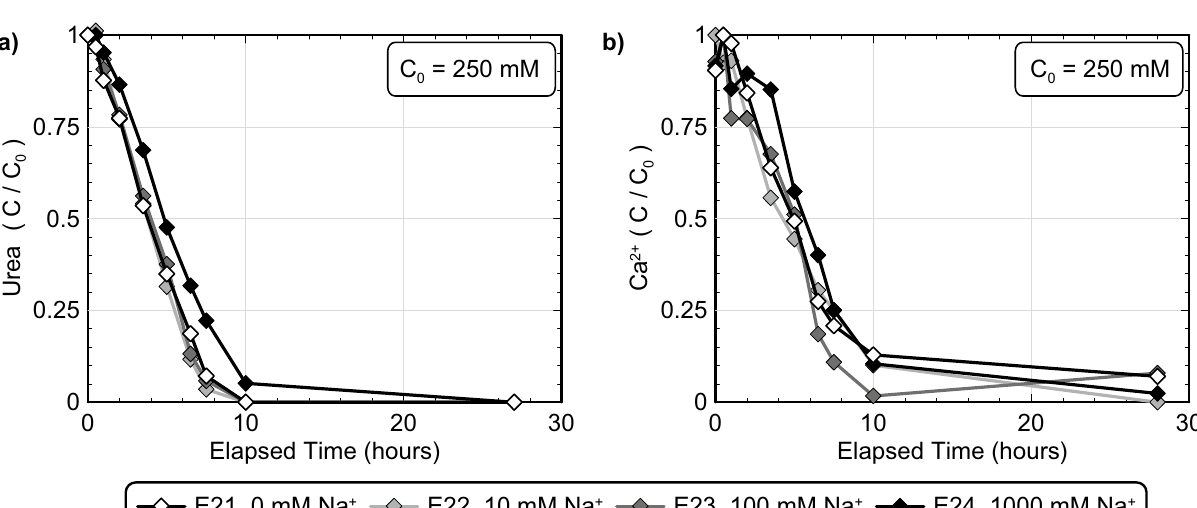
Figure 8. Normalized concentrations of ( a ) urea and ( b ) Ca 2+ in time for Na + varied experiments. All experiments included the addition of 250 mM urea, 250 mM Ca 2+ , S. pasteurii cells at 8.0 × 10 7 cells/mL and varying added Na +